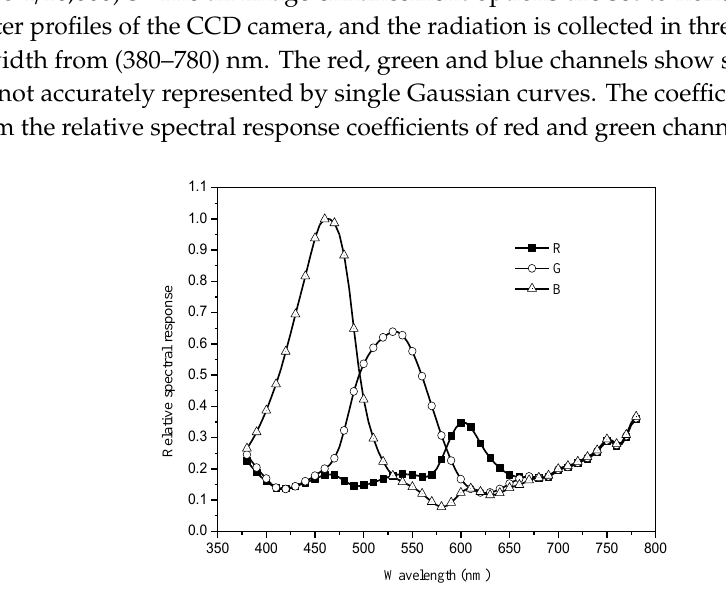
Figure 3. Filter profiles of the CCD camera.